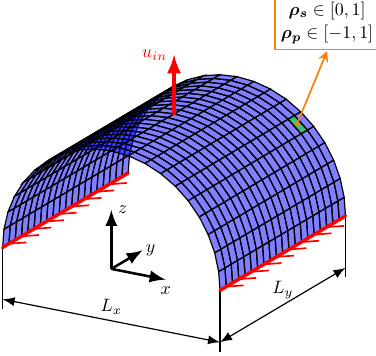
Figure 1. Dimensions and boundary